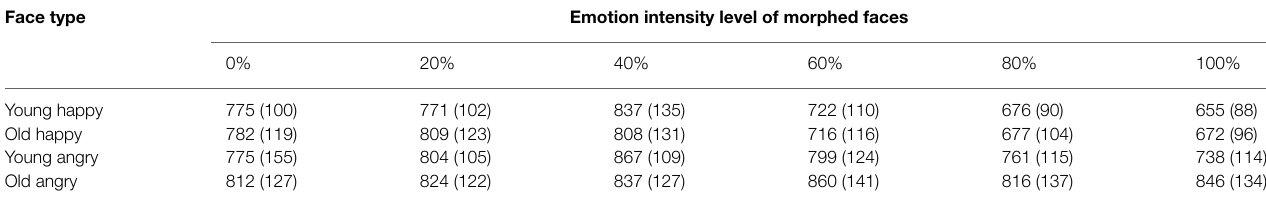
TABLE 2 | Means and standard deviations of the response time in milliseconds.